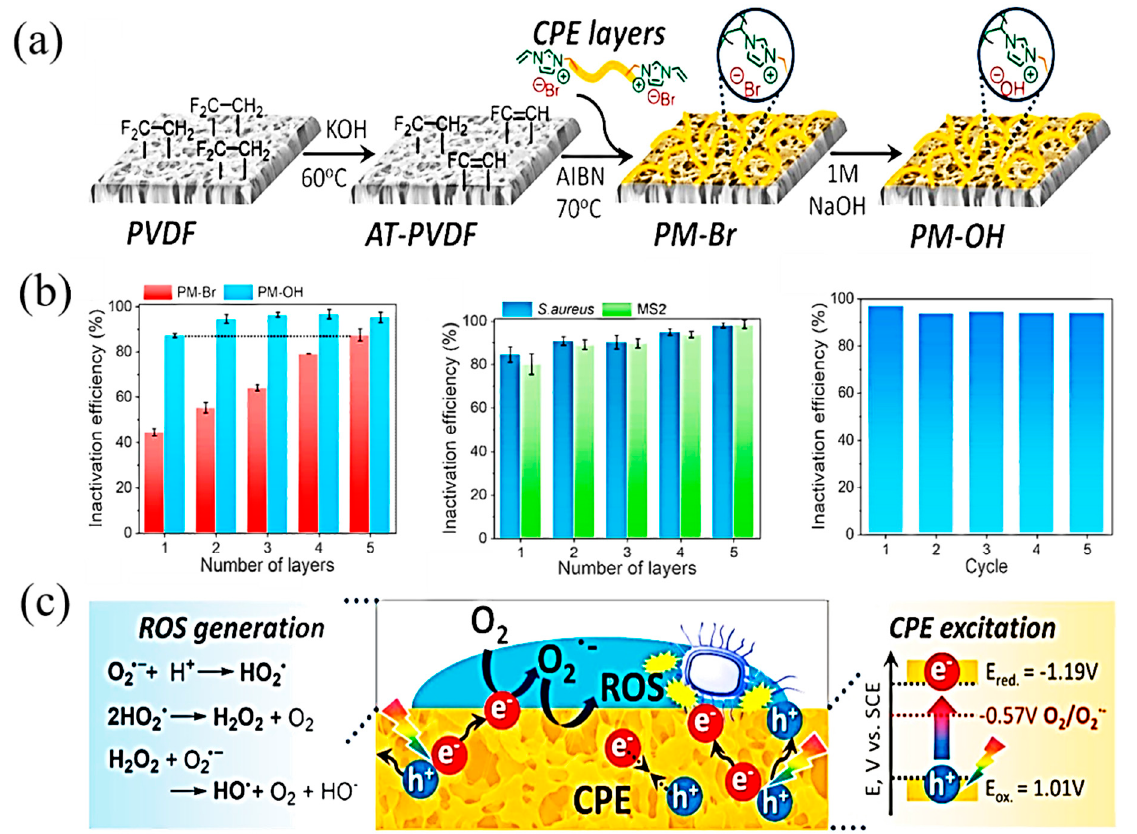
Figure 9. ( a ) Schematic illustration of synthetic procedure for the chemical tethering of CPE on a PVDF membrane to generate PMs. ( b ) Inactivation efficiency of E. coli on PMs with multiple CPE coating layers under visible light treatment for 1 h; Inactivation efficiency of S. aureus and MS2 on PM-OHs under visible light for 1 h; Cyclic experiment of E. coli inactivation over PM-OH-5L. ( c ) The proposed mechanism of antimicrobial activity on PM-OH [124]. (Copyright (2021) with permission from Elsevier Ltd.).